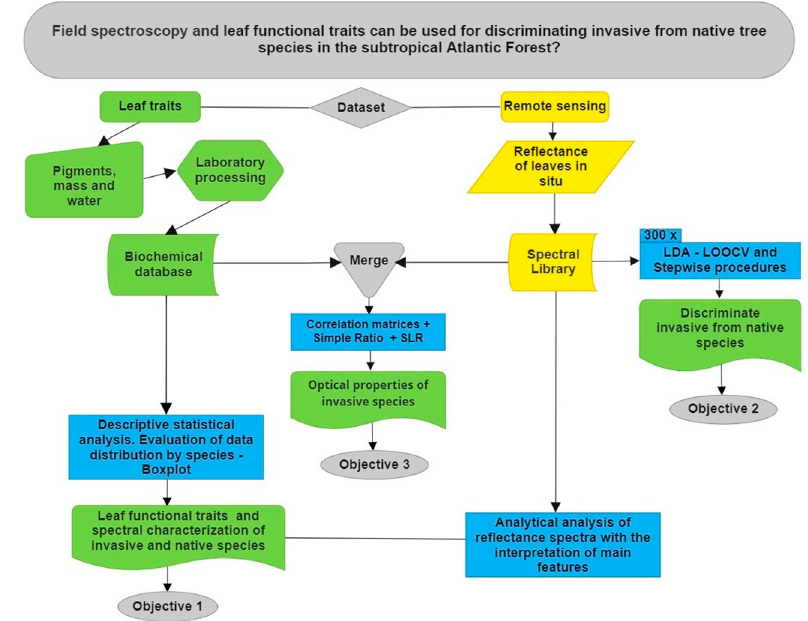
Figure 2. Schematic diagram illustrating flow of methodology. Detailed data processing and analyses are described in Section 2.6. Overall, steps represent data acquisition, data organization, processing and analysis, and